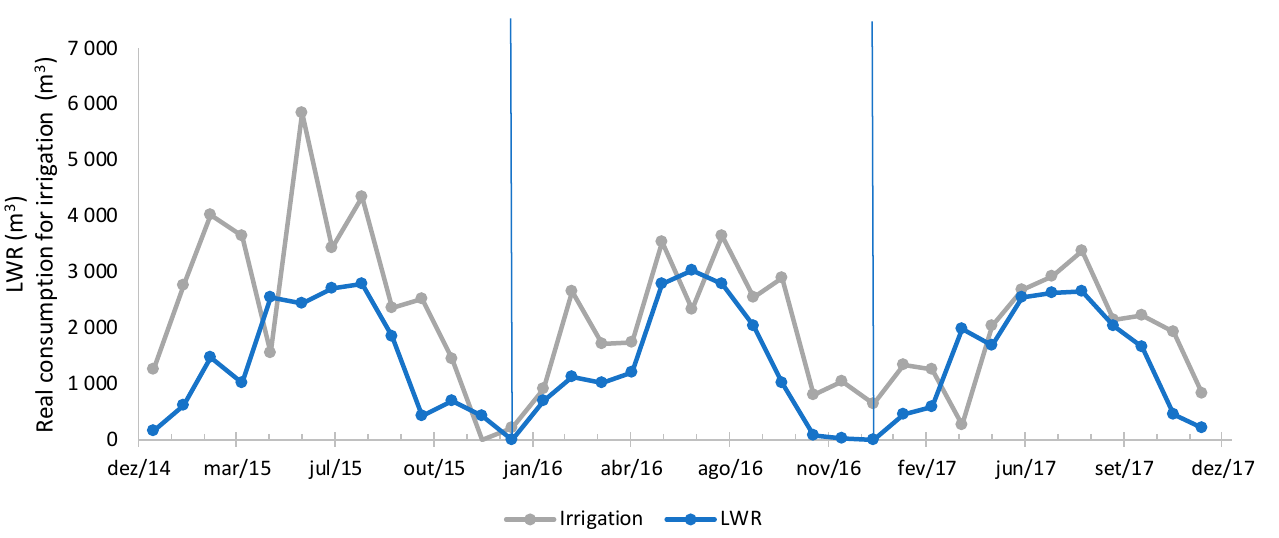
Figure 9. Landscape water requirements and system input volume in case study 2 in 2015, 2016 and 2017.